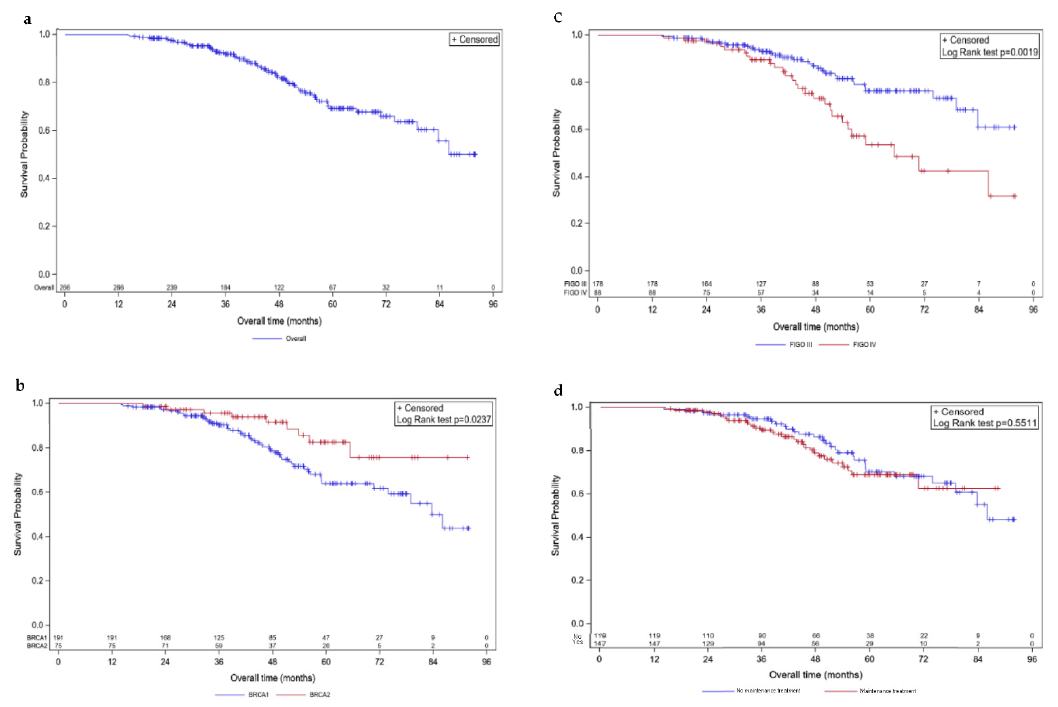
Figure 2. Kaplan–Meier overall survivals. Survival curves are given for overall population ( a ) and stratified according to mutated BRCA1 vs. BRCA2 ( b ), FIGO III vs. IV ( c ), and maintenance vs. no maintenance treatment ( d ).